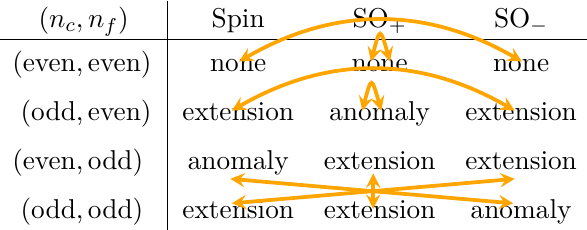
Table 1 . How the Z 2 1-form symmetry and the SU(2 n f ) / Z 2 0-form symmetry are combined in massless so (2 n ) QCD. ‘none’ implies that they remain a direct product without mixed anomaly; c ‘anomaly’ means that they remain a direct product but with mixed anomaly; and ‘extension’ is when they combine into a nontrivial 2-group. The orange lines show how the duality of Intriligator and Seiberg acts on this set of theories.